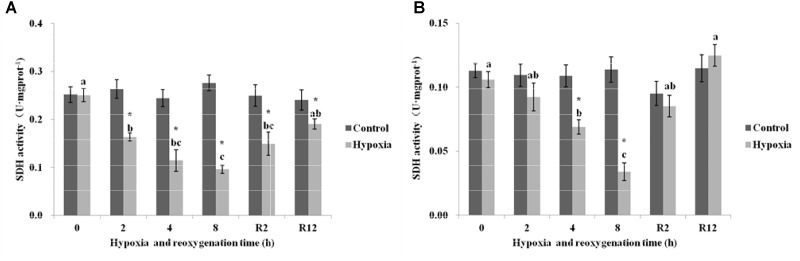
Effect of environmental hypoxia on SDH of E. sinensis
(A) and P. sinensis
(B). There was no significant difference between bars with the same letter (P < 0.05). Asterisk represents a significant difference between control and hypoxia groups at the same time point (P < 0.05).